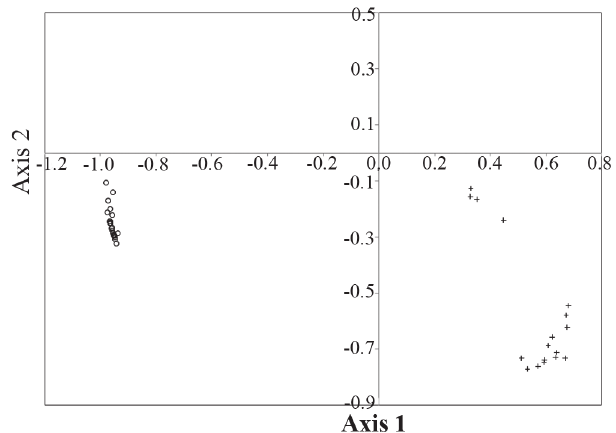
Fig. 2. Scores of the first two axes derived via principal component analysis (PCA), which analysed CPUE data on fish captured by the artisanal fisheries in the two reservoirs during the study period. cross = Jurumirim Reservoir; circle = Barra Bonita